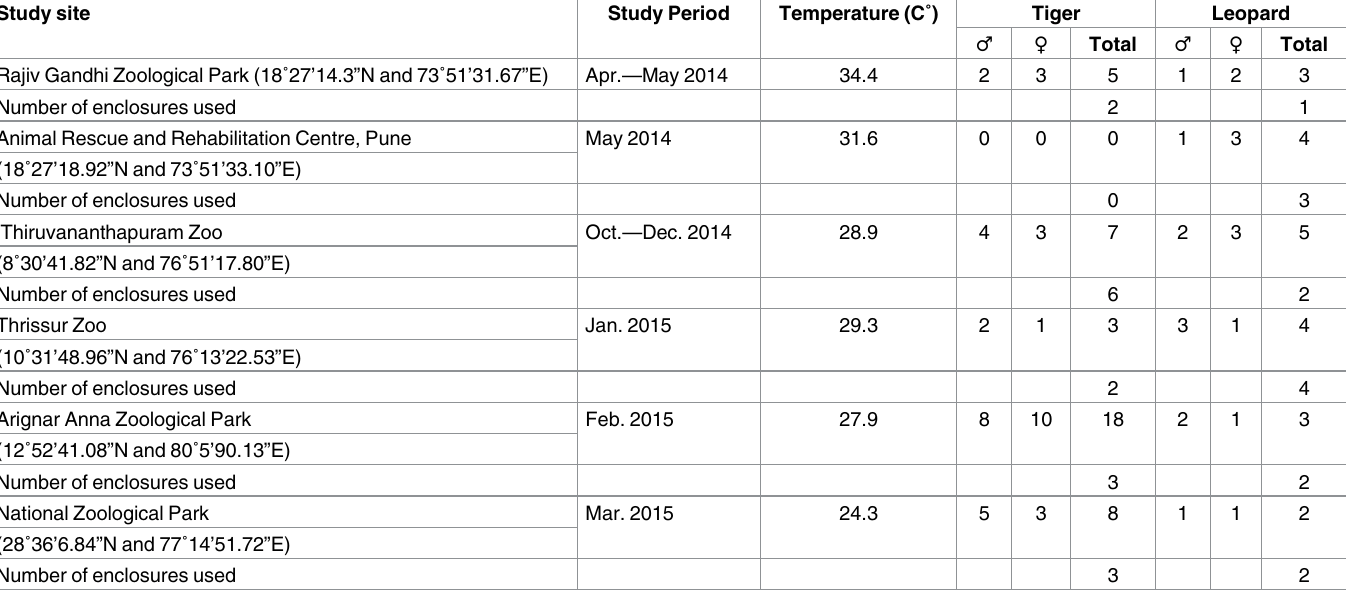
Table 1. Details of various study sites and study